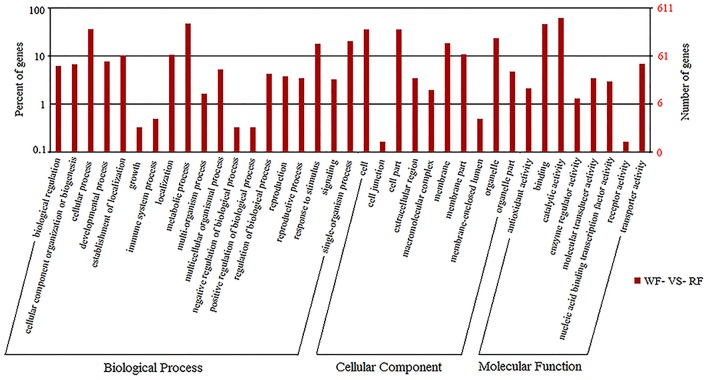
The GO frequencies and the numbers of gene in each term were shown in histograms.